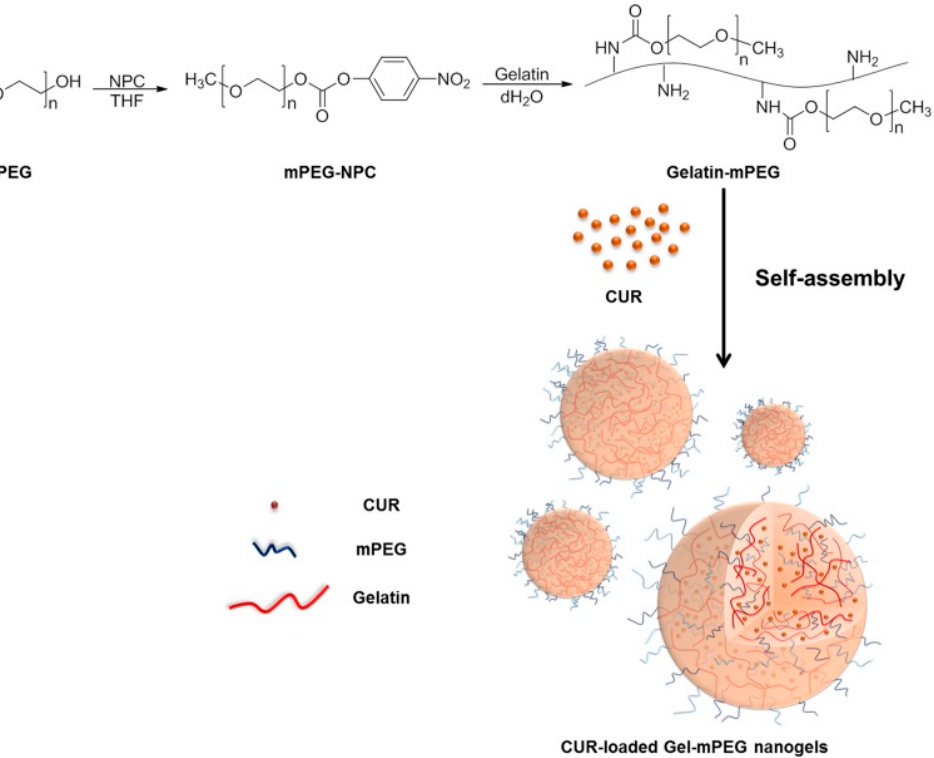
Figure 8. Representation for the preparation of curcumin-loaded gelatin—poly(ethylene glycol) (PEG) nanogels [reprinted from 402, open access].